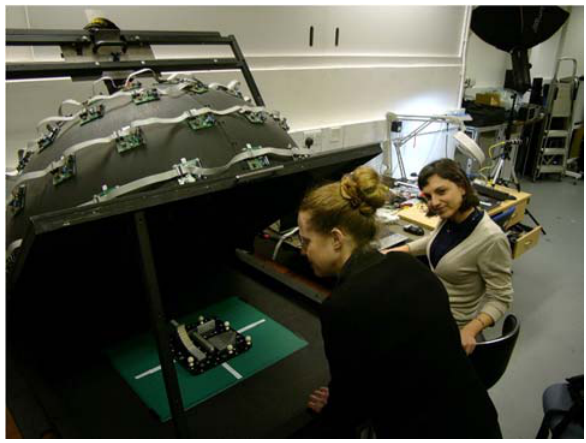
Figure 2. Positioning 3D test object on baseboard of dome. Three image sets were taken by a Nikon D200 camera. Raw images of 3900x2600 pixels were captured in NEF format. The 17-55mm 1:2.8GED Nikkor DX zoom lens was set to a nominal focal length of 35mm, focal distance 0.65m and aperture f/8, and the zoom and focus rings were taped to prevent movement during the photography in all three phases.